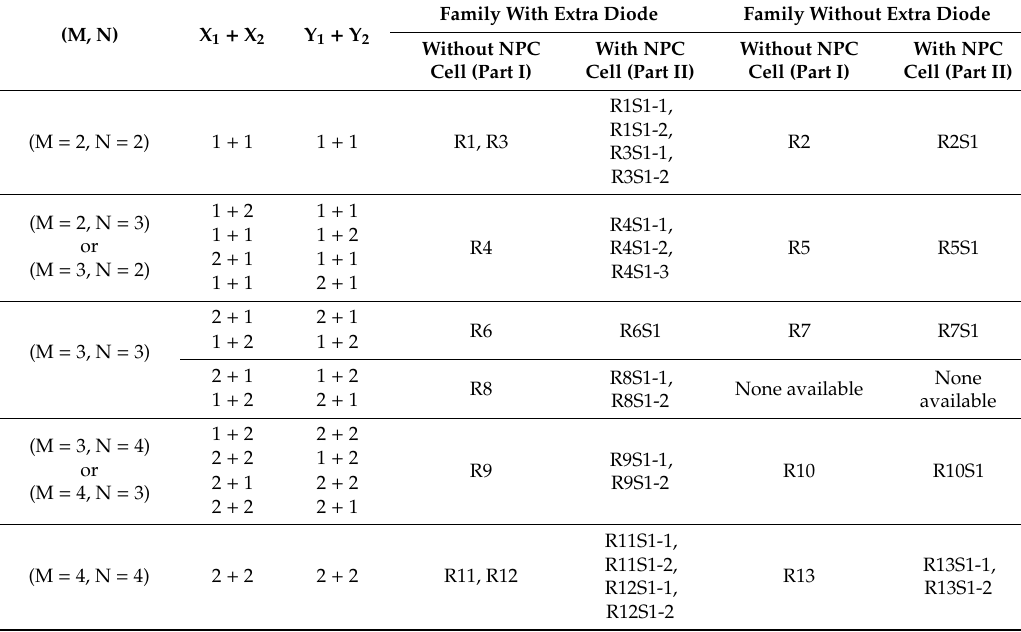
Table 1. Two inverter topology families from USPWM.